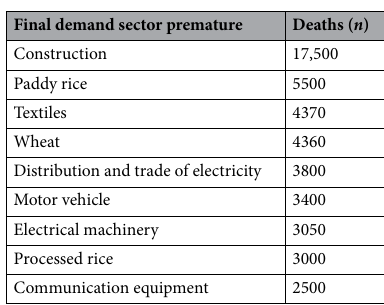
Table 1. Highest PM 2.5 -related health impacts induced by electricity consumption in domestic final demand sectors in